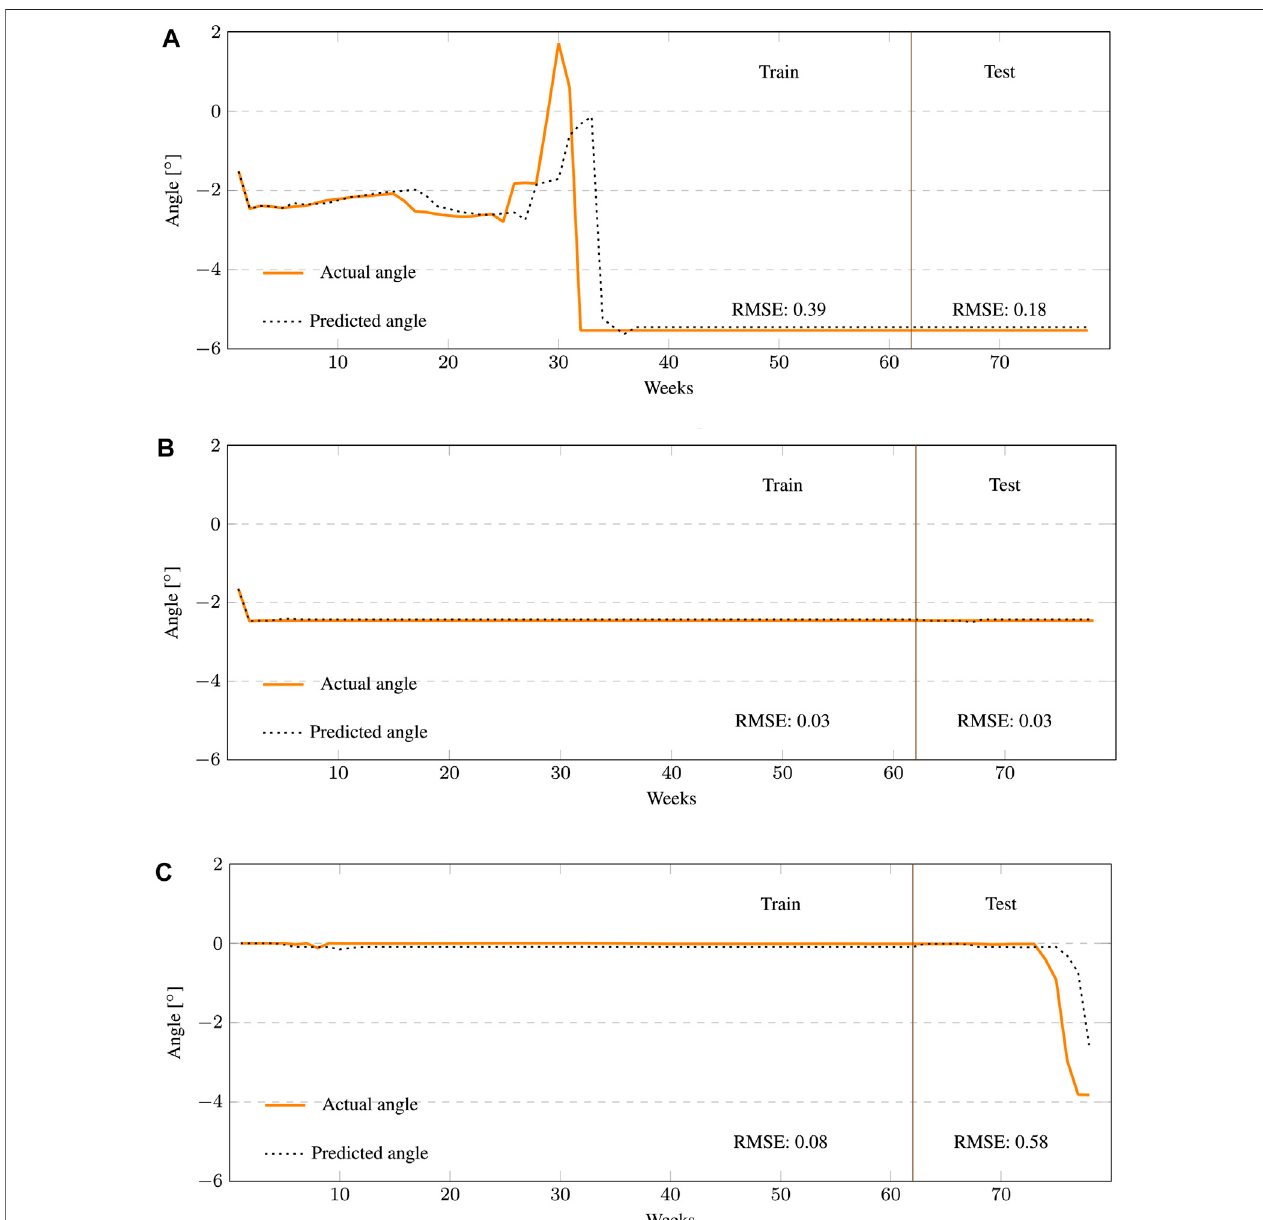
FIGURE 8 | The best performing BS-LSTM model showing the soil movements (in degree) over the Tangni landslide training and test datasets. (A) The sensor at 3 m in borehole one at Tangni. (B) The sensor at 12 m in borehole two at Tangni. (C) The sensor at 6 m in borehole three at Tangni. (D) The sensor at 15 m in borehole four at Tangni. (E) The sensor at 15 m in borehole fi ve at Tangni. (F) The best performing BS-LSTM model showing the soil movement (in meters) over the Kumarhatti ’ s training and testing datasets.